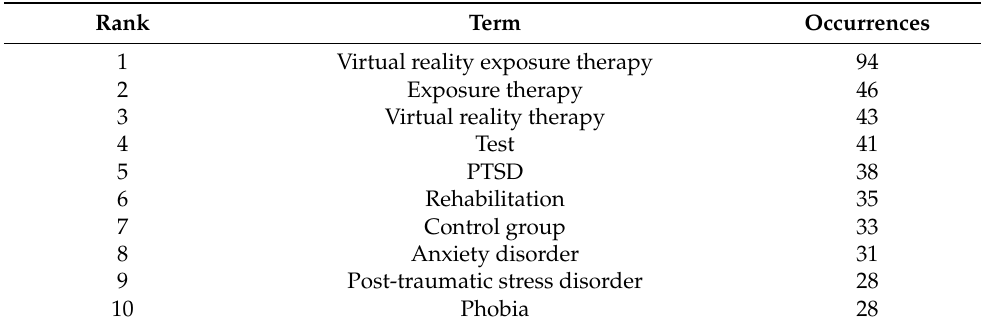
Table 2. The most frequent terms on the theme of VR and therapy in the Web of Science core collection (WoSc) database calculated by VOSviewer (devised by the authors).